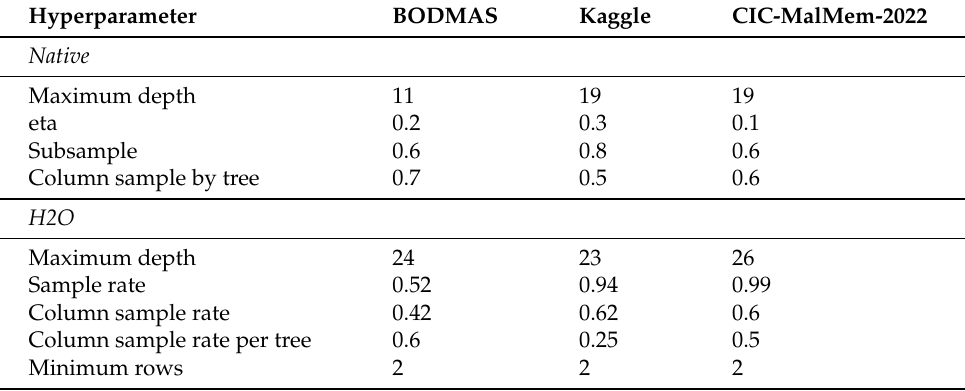
Table 3. The final learning parameters of XGBoost used for each dataset after performing a ran- dom search